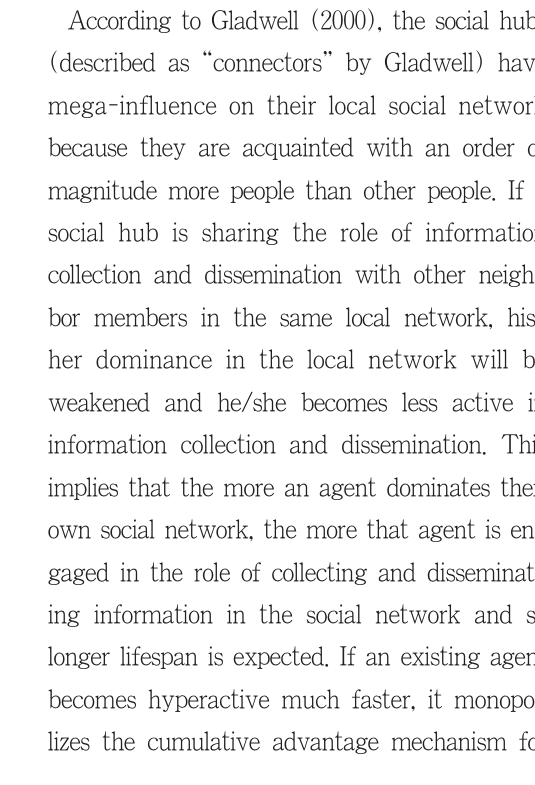
The Lifespan of Social Hub In Social Networking Sites: The Role of Reciprocity, Local Dominance and Social Interaction